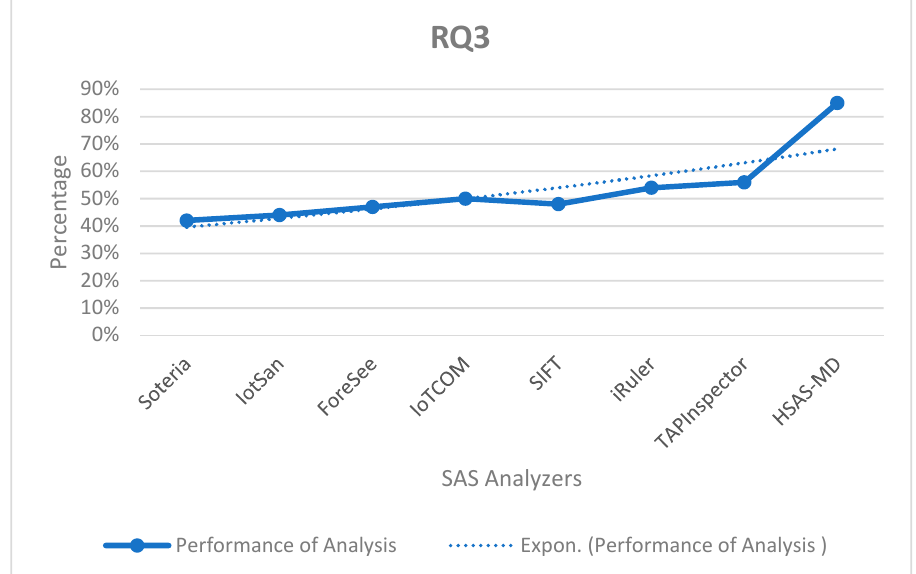
Figure 15. The performance of the proposed HSAS-MD analyzer with other related analyzers based on the analysis type.